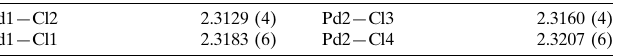
Selected bond lengths (A˚ ).